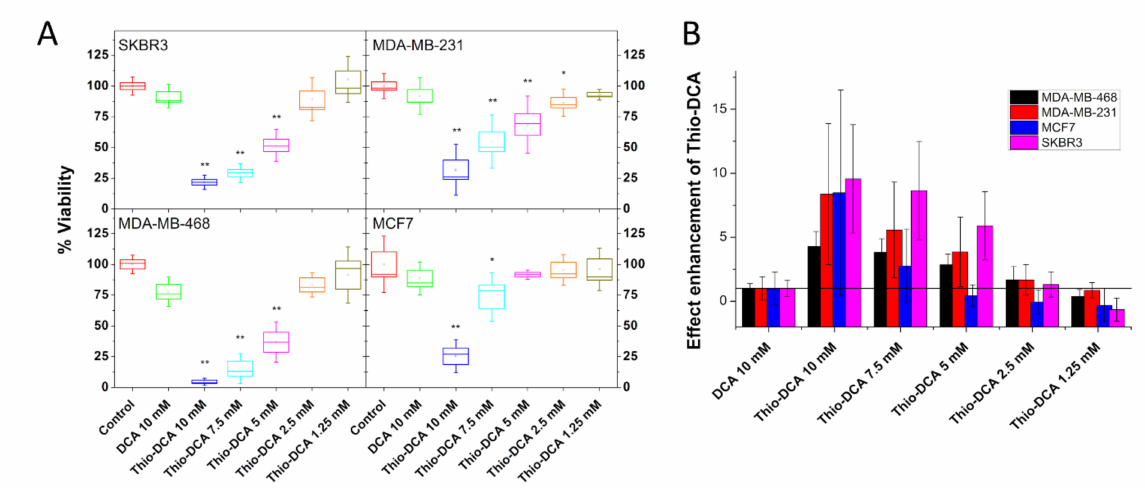
Figure 2. ( A ) Cell viability of SKBR3, MDA-MB-231, MDA-MB-468, and MCF7 breast cancer tumor cells treated with DCA and Thio-DCA at different doses. Squares indicate mean values, box size indicates the standard error of the mean, and whiskers represent the standard deviations. The marked populations were significantly different from the control with 99% (**) or 95% (*) confidence, as indicated by the Holm-Bonferroni and Holm-Sidak tests and the nonparametric Kolmogorov-Smirnov and Mann-Whitney tests. ( B ) Relative enhancement of the reduction in cell viability of Thio-DCA at different doses compared to that of 10 mM